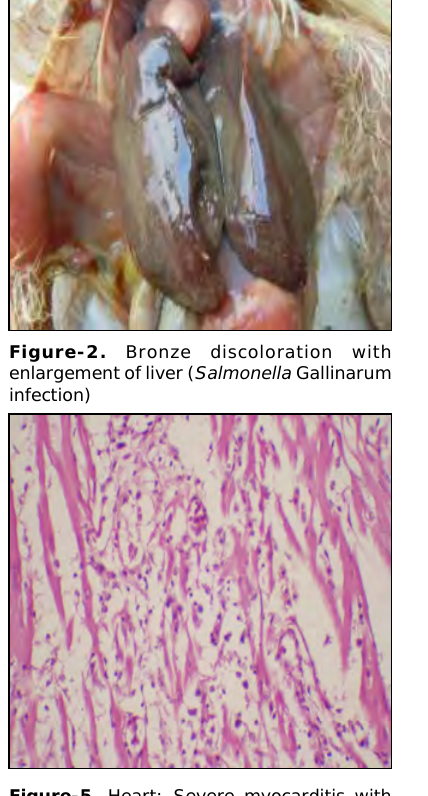
Figure-5. Heart: Severe myocarditis with fragmented myocardial muscle fibres along with infiltration of lymphocytes and heterophils ( Salmonella Gallinarum infection)H & E x 33